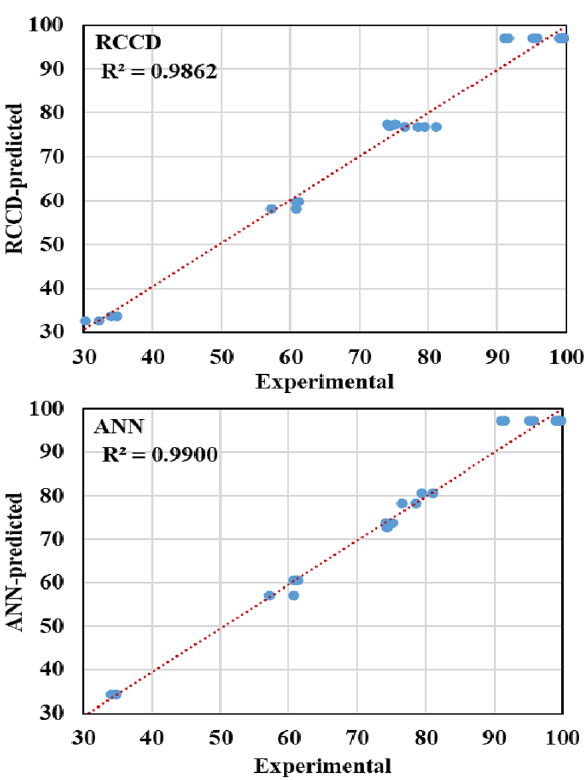
Figure 3. Actual versus RCCD and ANN predicted values for chromium removal by P. alcaliphila